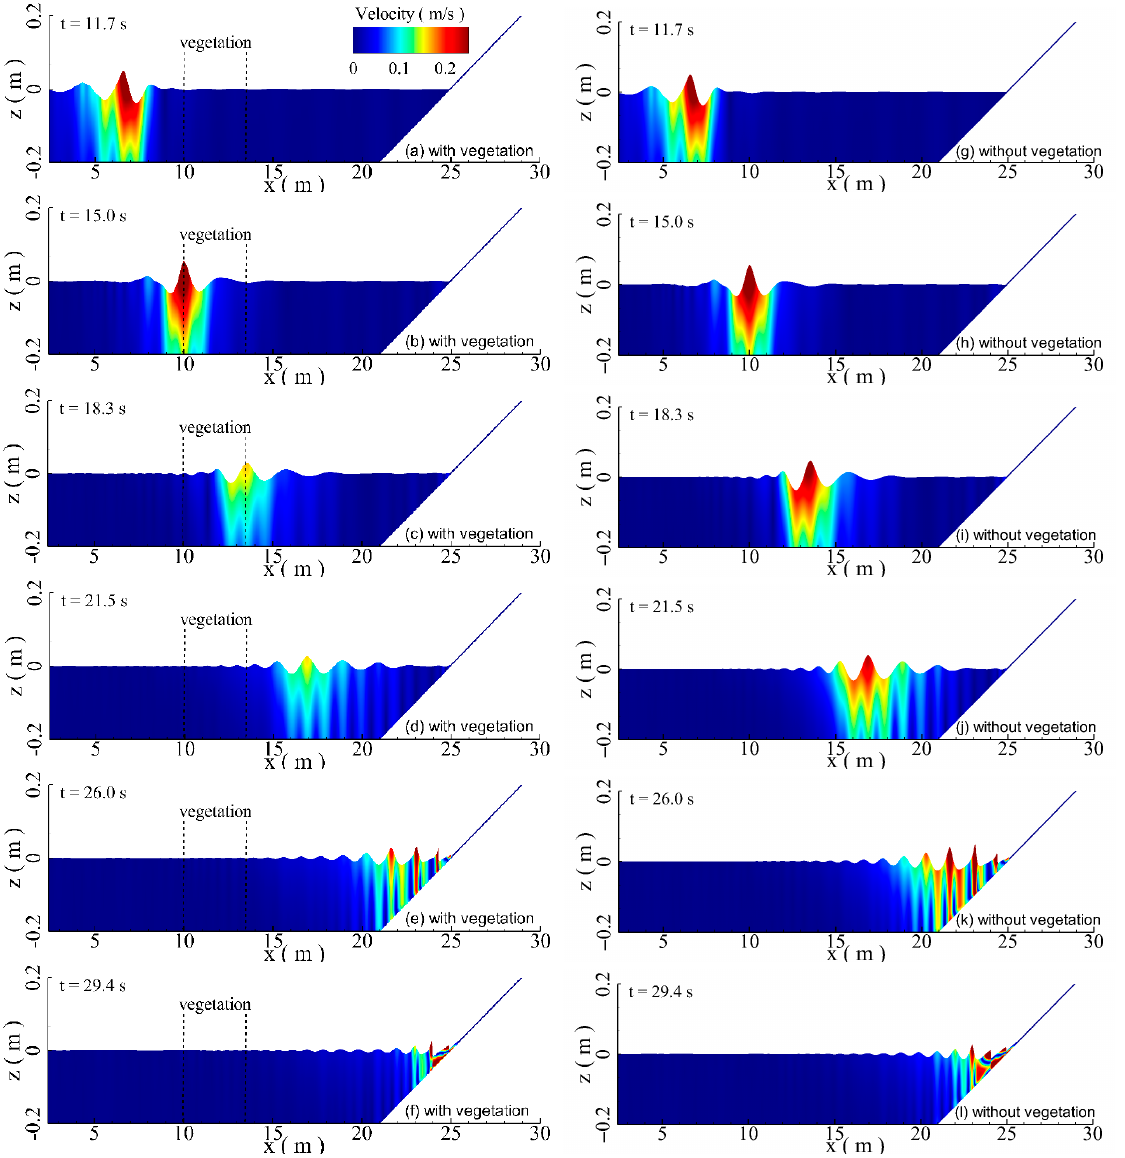
Figure 7. Water velocity contours at different times; left side: with the vegetation patch; right side: without the vegetation patch.